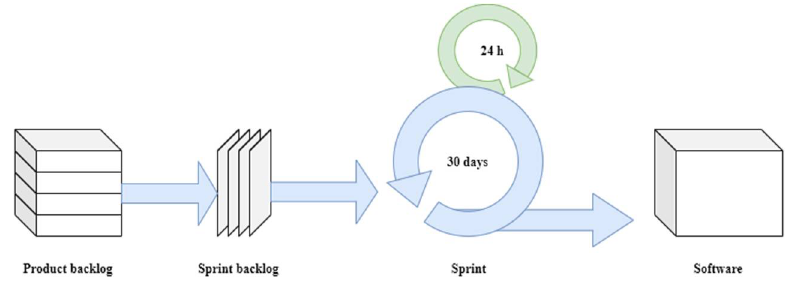
Figure 1. The Scrum